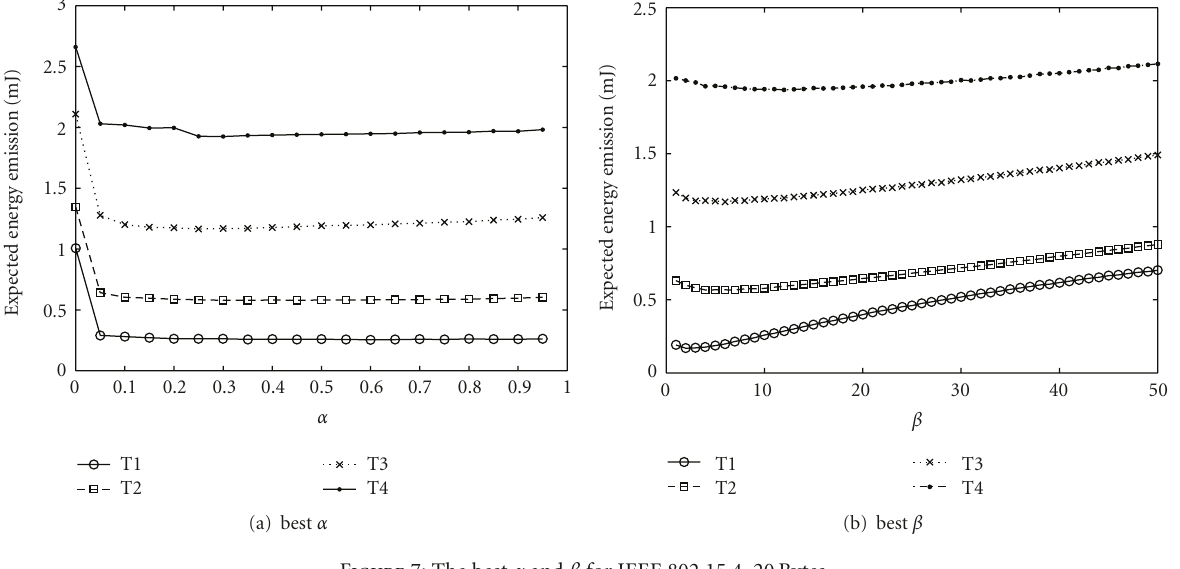
Figure 7: The best α and β for IEEE 802.15.4, 20Bytes.